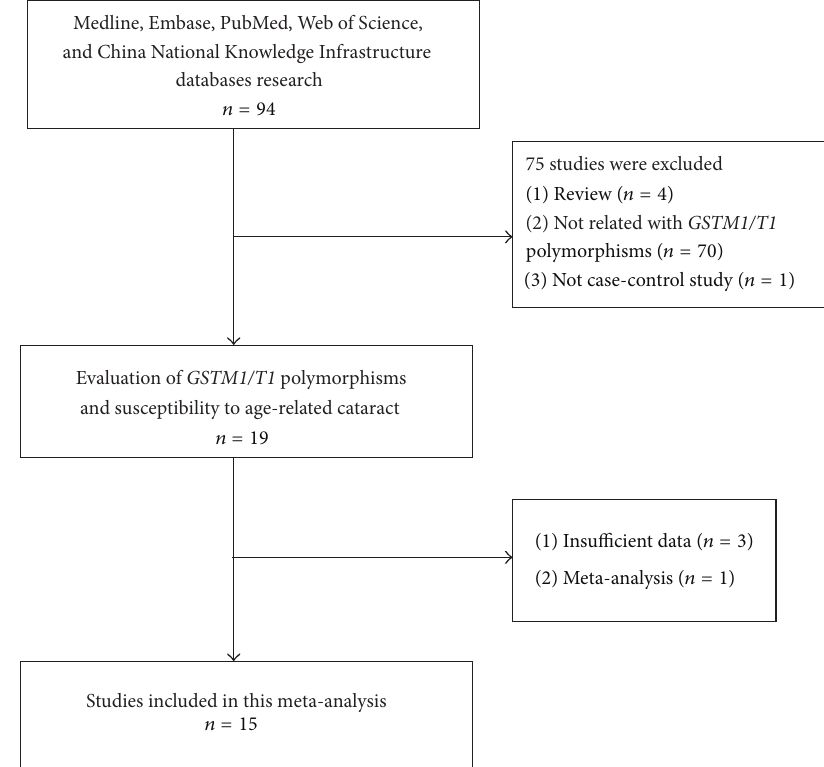
Figure 1: Flow chart showing study selection